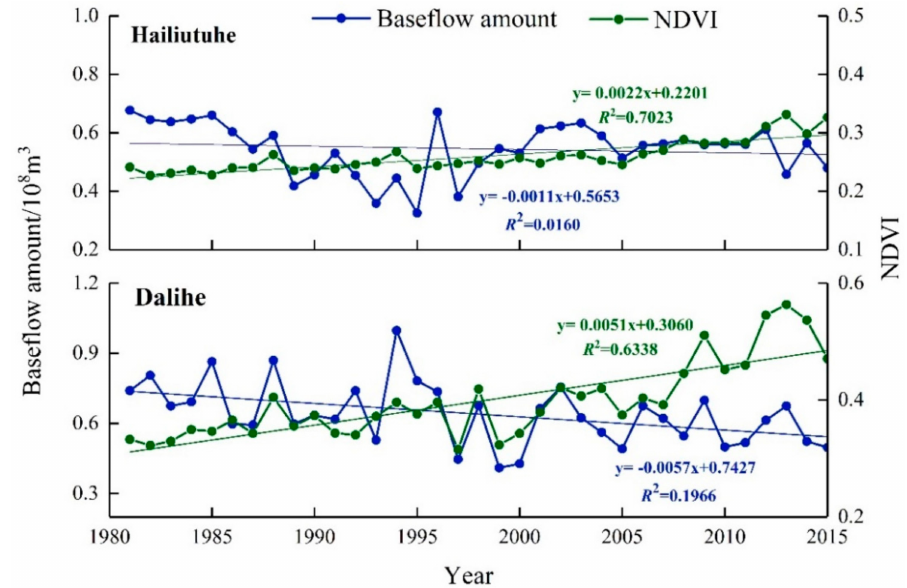
Figure 5. Variation trend of Baseflow amount and normalized di ff erence vegetation index (NDVI) for two